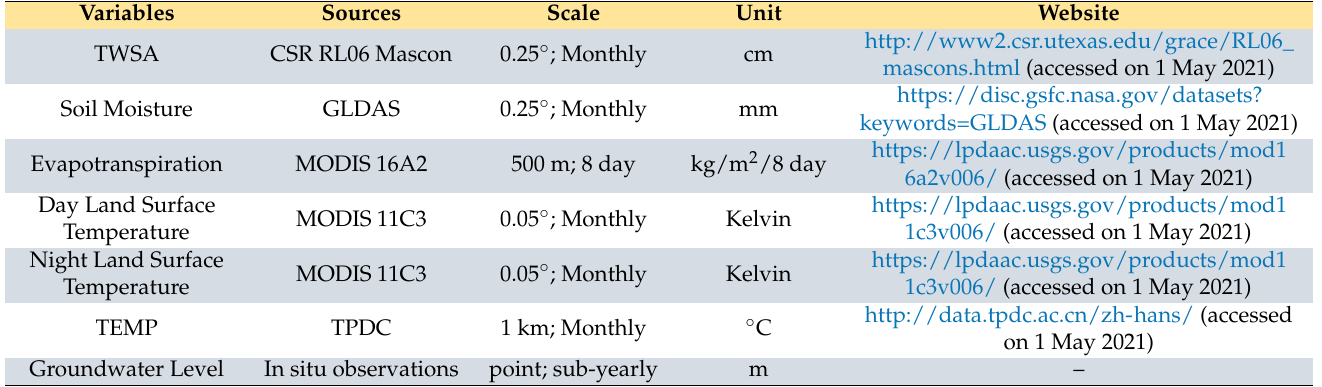
Table 1. Summary of variables (Sources, Scale, Unit, and Website) employed in the